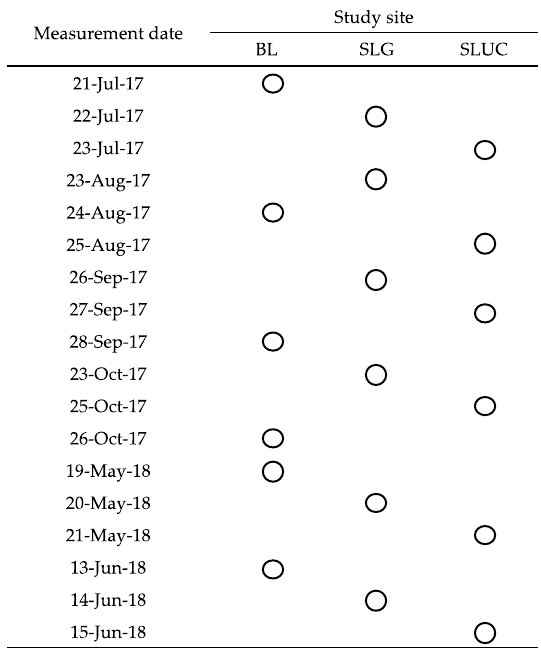
Plants 2020 , 9 , x FOR PEER REVIEW 13 of 16 Figure A2. Landscape of bare land ( a ) and shrub land gap ( b ), shrub land under canopy ( c ).